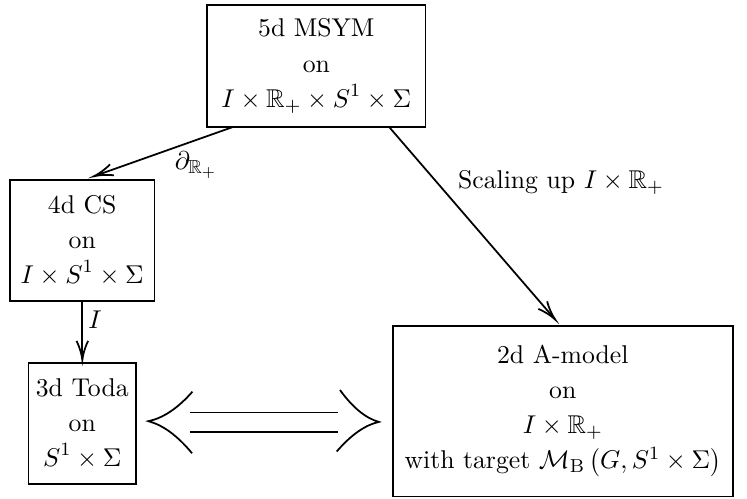
Figure 4 . Outline of the steps taken in this paper, repeated here for